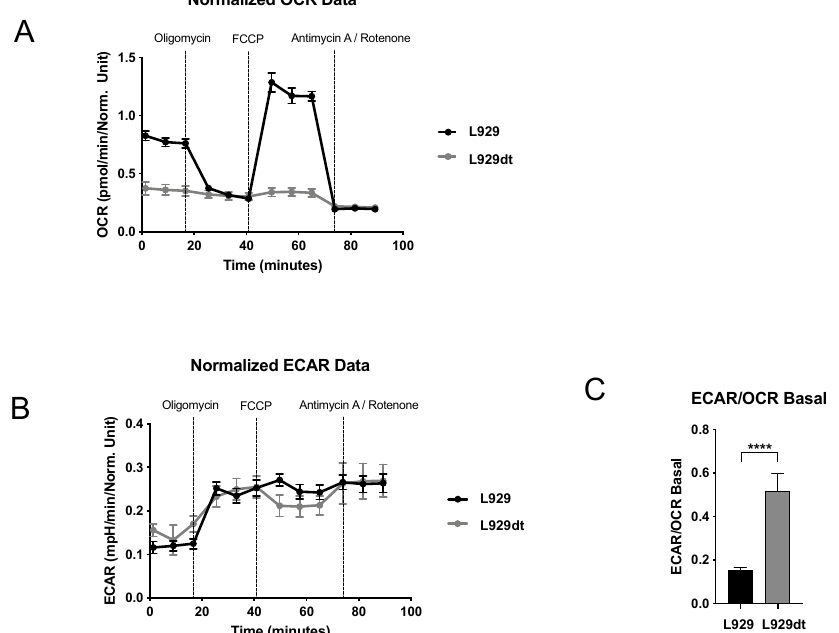
Figure 2. Analysis of mitochondrial respiration and glycolysis. ( A ) Oxygen consumption rate (OCR) and ( B ) extracellular acidification rate (ECAR) measurement upon sequential addition of oligomycin, FCCP, and rotenone + antimycin A in L929 (black dots) and L929dt (grey dots) cells using the Seahorse XF96 Extracellular Flux Analyzer. ( C ) ECAR to OCR ratio at basal respiration in both cell lines. Data are given as mean ± SEM with 8 independent assays per cell line. Asterisks indicate significant differences respect to L929 cells p < 0.0001 using non parametric Mann Whitney test.